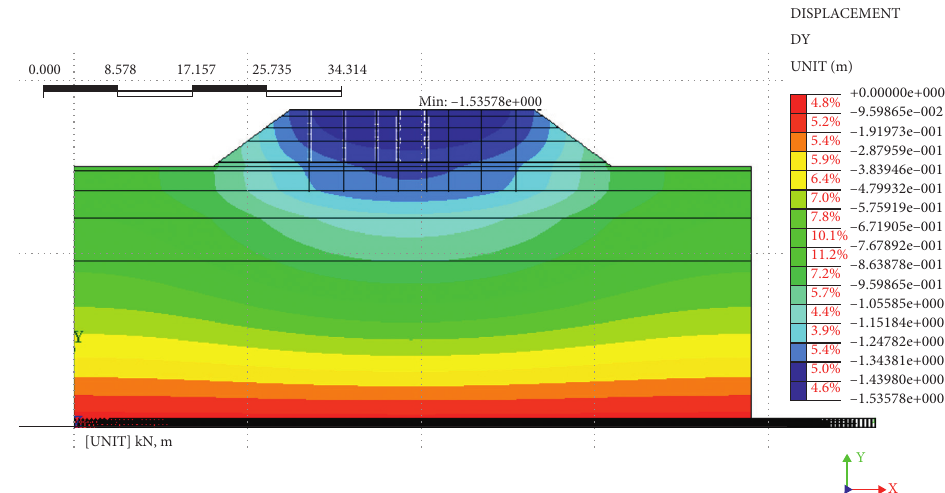
Figure 7: Model results for vertical displacement following micro-pile